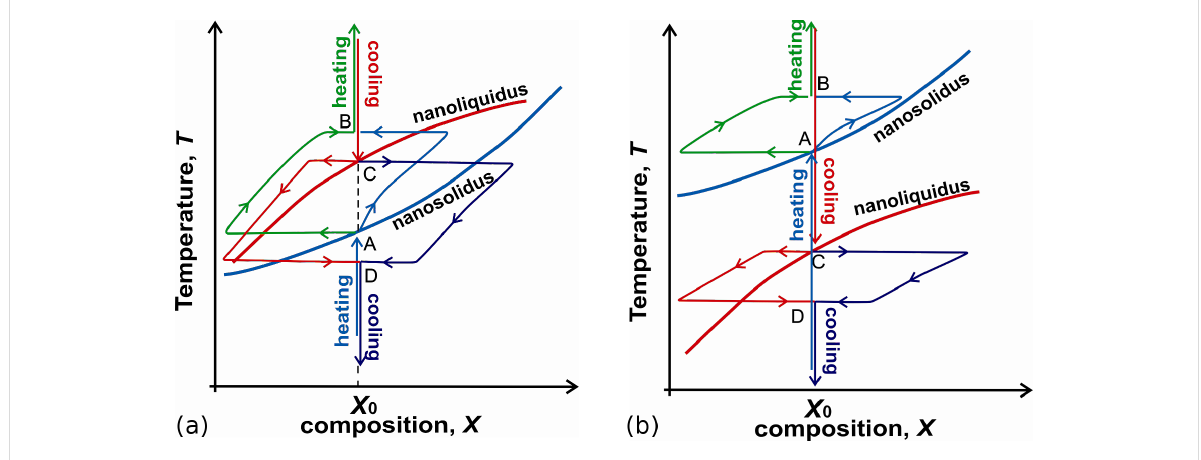
Figure 5: The nanomelting and nanosolidification loops in T–X phase diagram in two-phase region for an individual nanoparticle of fixed composition X 0 : (a) – the solid-to-liquid loop starts at point A of nanosolidus curve (blue) and ends at point B (green) which is higher than point C for nanoliquidus (red); the liquid-to-solid loop starts at point C of nanoliquidus curve (red) and ends at point D (purple) which is lower than point A for nanosolidus (blue); (b) – nanomelting starts at higher temperatures than the nanosolidification temperatures. The increasing of the sizes leads to the vanishing of the hysteresis effect.